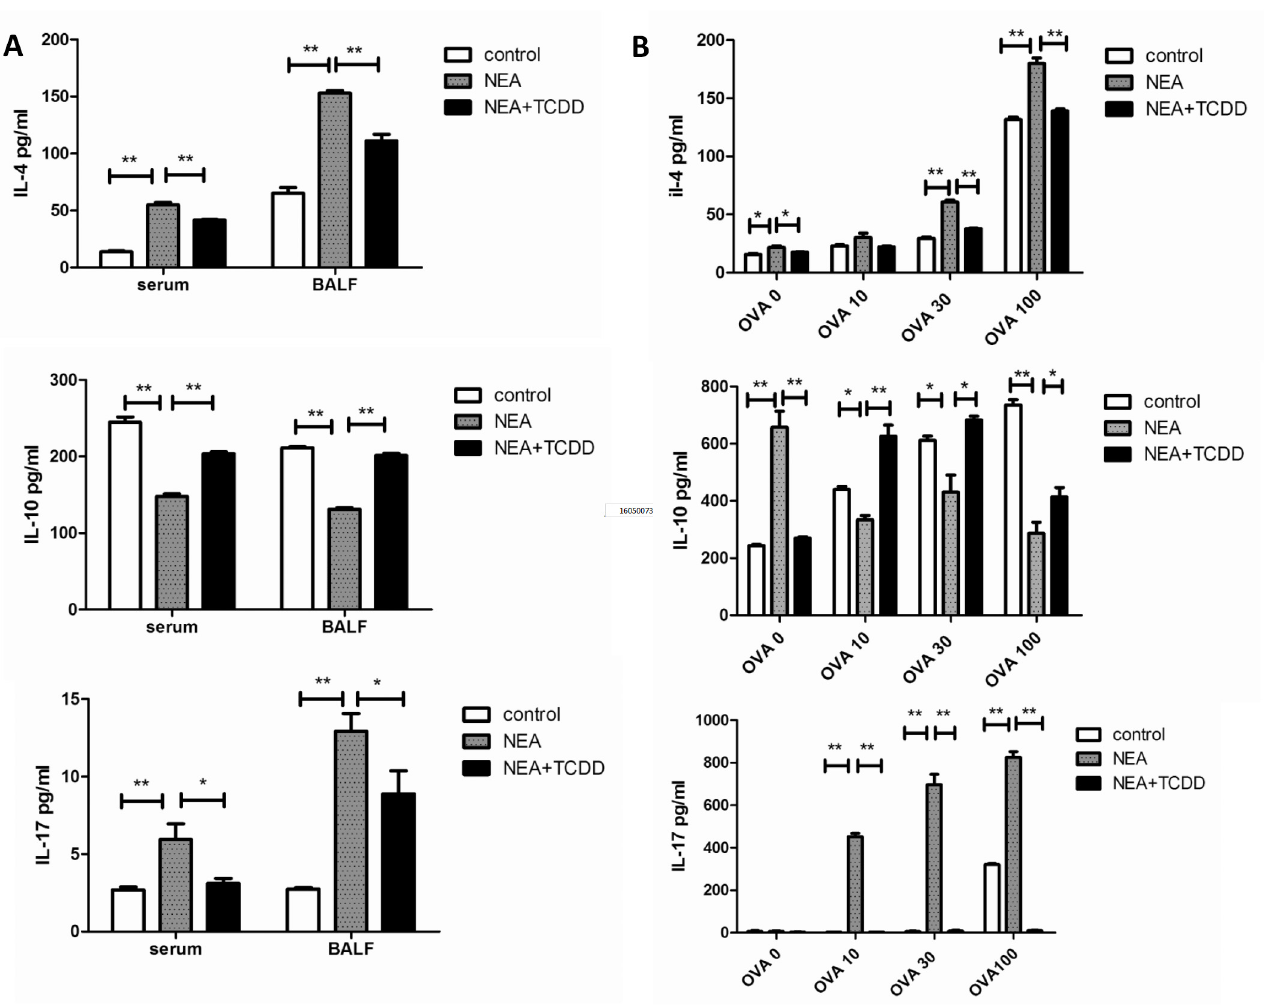
Fig 4. TCDD-induced AhR activation enhanced IL-10 expression and inhibited IL-17 and IL-4 expression. (A) Cytokine expression in the serum and BALF was determined via ELISA. (B) Cytokine expression from the OVA-specific T cells was determined via ELISA. N = 5 per group and * P < 0.05, ** P <